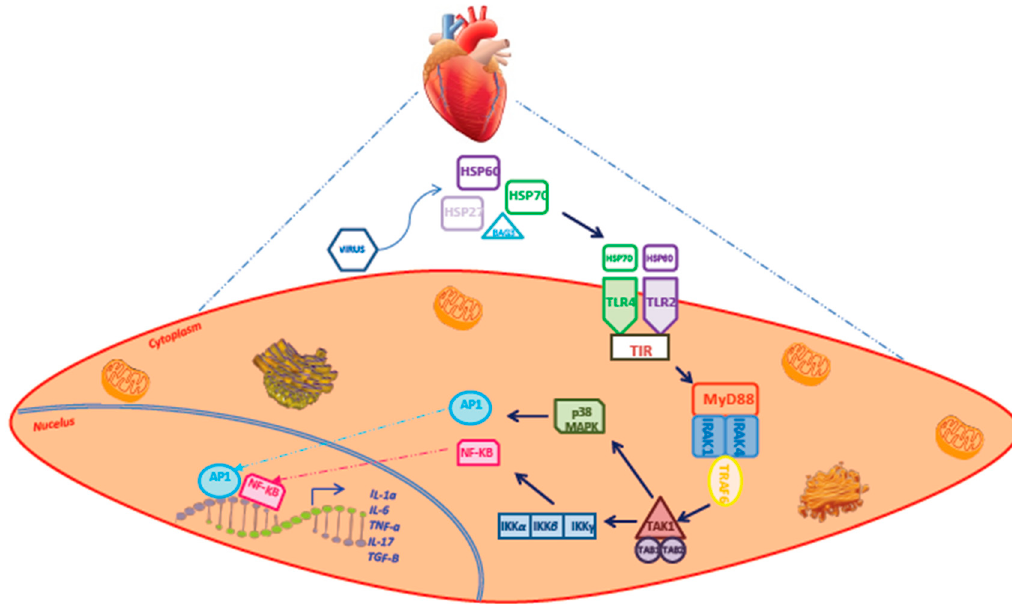
Figure 1. Schematic representation of NF- κ B and MAPK pathways. Chaperone proteins are released by cardiac cells and bind to surface receptors on cardiac cell types activating specific signaling chronic inflammation. Cell surface toll-like receptors (TLR) are activated by Pathogen-Associated Molecular Patterns (PAMPs) or Danger-Associated Molecular Patterns (DAMPs) to initiate intracellular signaling. Myeloid Di ff erentiation Primary Response 88 (MYD88) binds to Interleukin-1 Receptor-Associated Kinase 4 (IRAK4) and IRAK1 / 2. The IRAK complex interacts with TNF Receptor Associated Factor 6 (TRAF6). TRAF6 forms a complex with Mitogen-Activated Protein Kinase Kinase Kinase 7 (MAP3K7 or TAK1), MAP3K7 Binding Protein 1 (TAB1) and 2 (TAB2). TAK1 then activates the I κ B Kinase (IKK) complex, thus activating the Nuclear Factor Kappa B (NF- κ B). The released NF- κ B translocates into the nucleus and mediates the expression of a number of proinflammatory cytokine genes. In addition, TAK1 can activate the Mitogen-Activated Protein Kinase (MAPK) signaling pathway. The MAPK signaling pathway can activate the transcription factor Activator Protein 1 (AP-1). The activation of NF- κ B and AP-1 contributes to the expression of proinflammatory cytokines, such as IL-1, IL-6 and TNF- α .